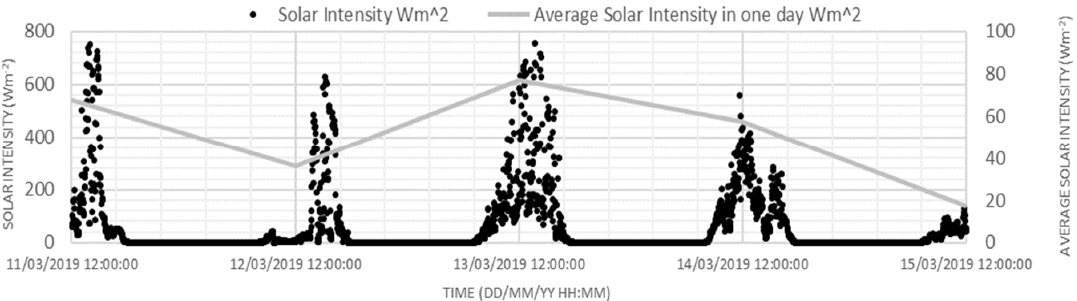
Figure 14. The measured solar intensity in the second week.